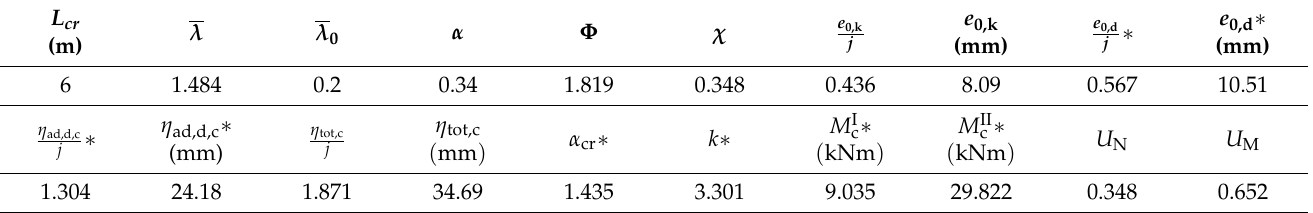
= 1.0 , and 𝑁 (cid:2897)(cid:2869)